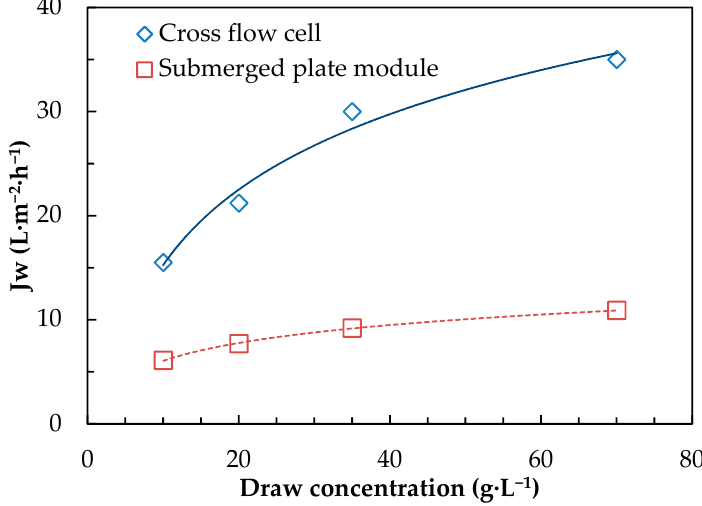
Figure 4. Comparative water permeation flux ( Jw in L · m − 2 · h − 1 ) as a function of SW draw solution concentration (g·L − 1 ) using DI water as feed for the CFC and submerged plate module (a pumping flow rate of 0.3 L·min − 1 for both setups, no stirring for the submerged FO module).